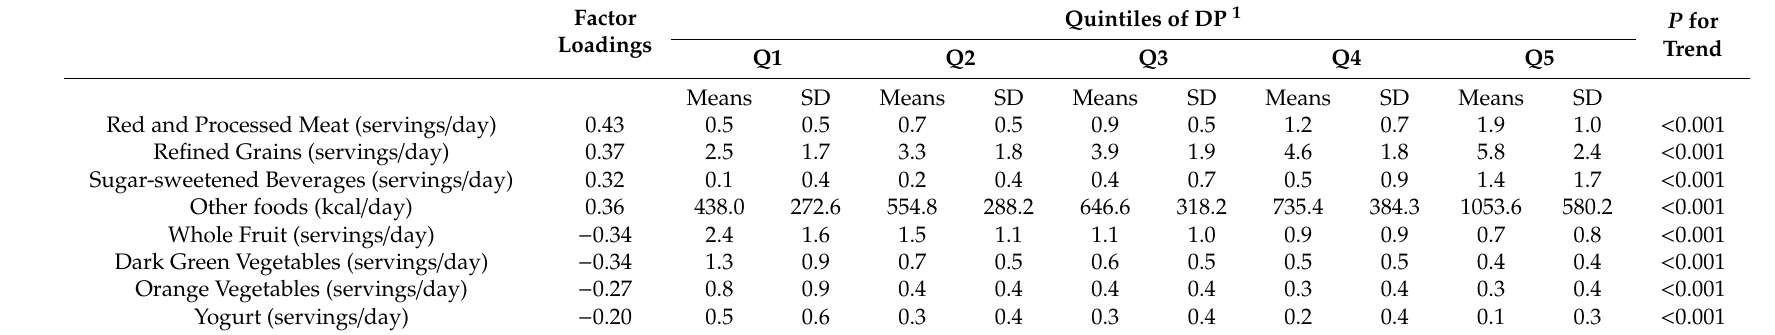
Table 3. Intake of key food groups (predictors) across quintiles (Q) of the selected dietary pattern (DP) ( N = 998). Factor Loadings